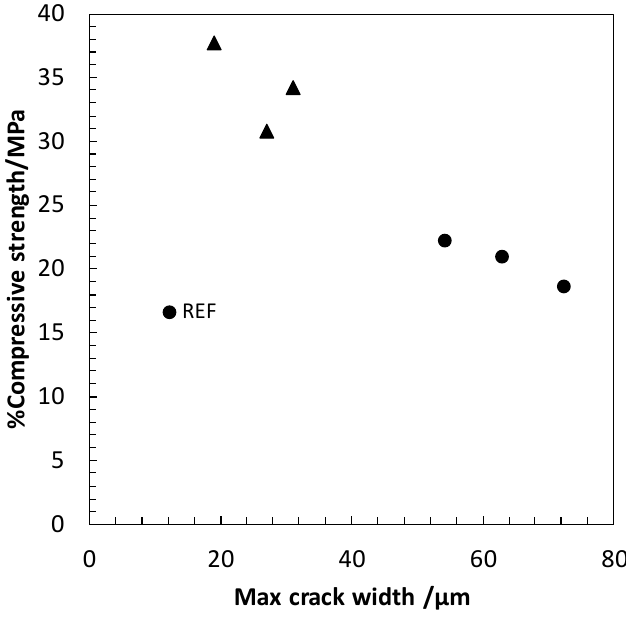
Figure 10. Percentage of residual compressive strength versus crack width for concrete with and without CNT+CMF after 1, 25, and 75 heat cycles (290.550 °C).